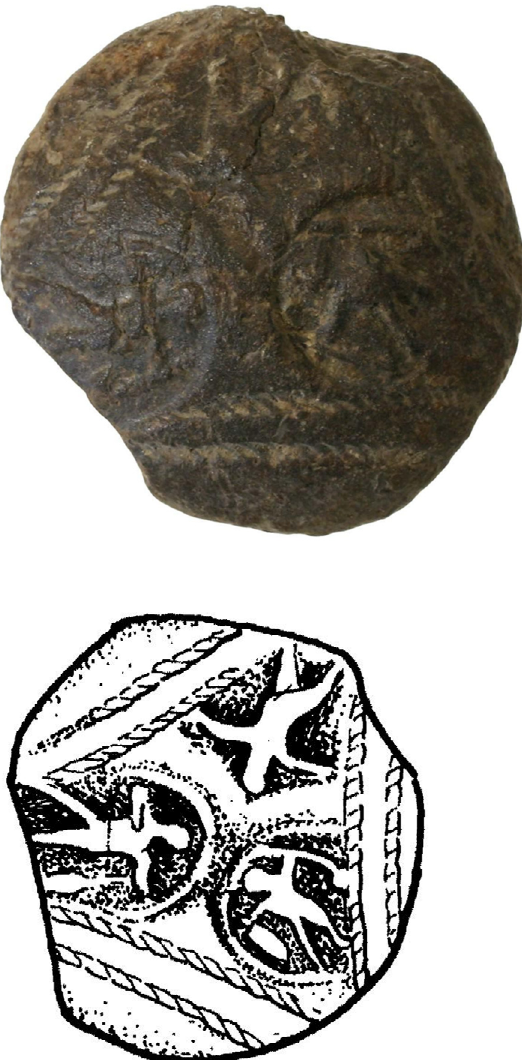
Figure 7. Impasto rocchetto head and drawing illustrating a repeating warrior stamp, ca. 675/650–535 BCE (Image: Poggio Civitate Project).